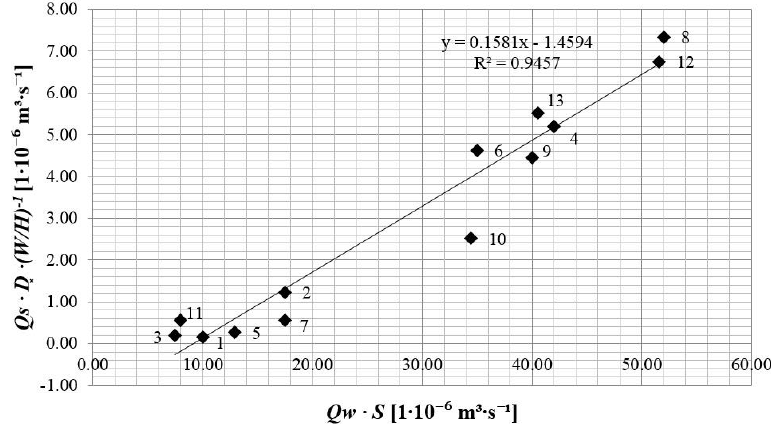
Figure 9. Modified Lane’s relation graph; 1–13 are the numbers of the measurements (compare with Tables 1 and 2).